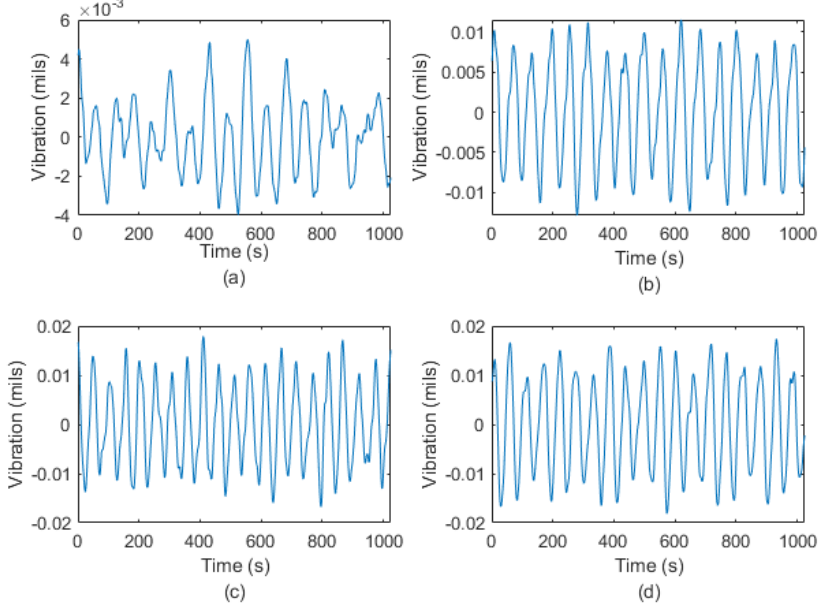
Figure 8. Different vibration signals for gas turbine rotor system faults. ( a ) Normal state. ( b ) Airflow excitation. ( c ) Unbalanced. ( d )